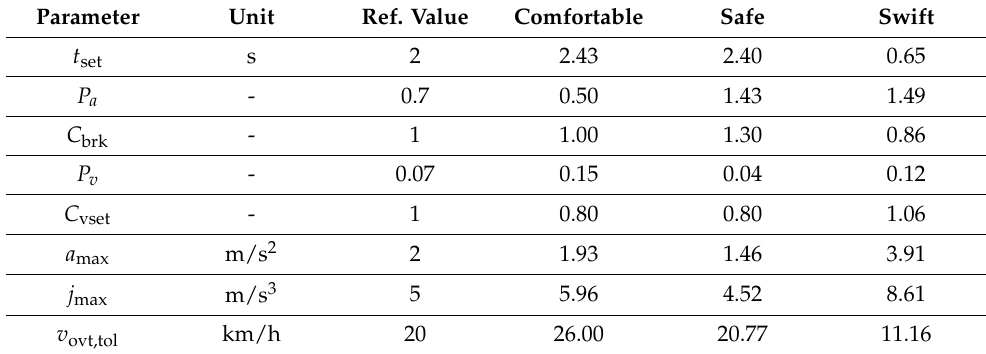
Table 6. Setting parameters for the selected driving styles.